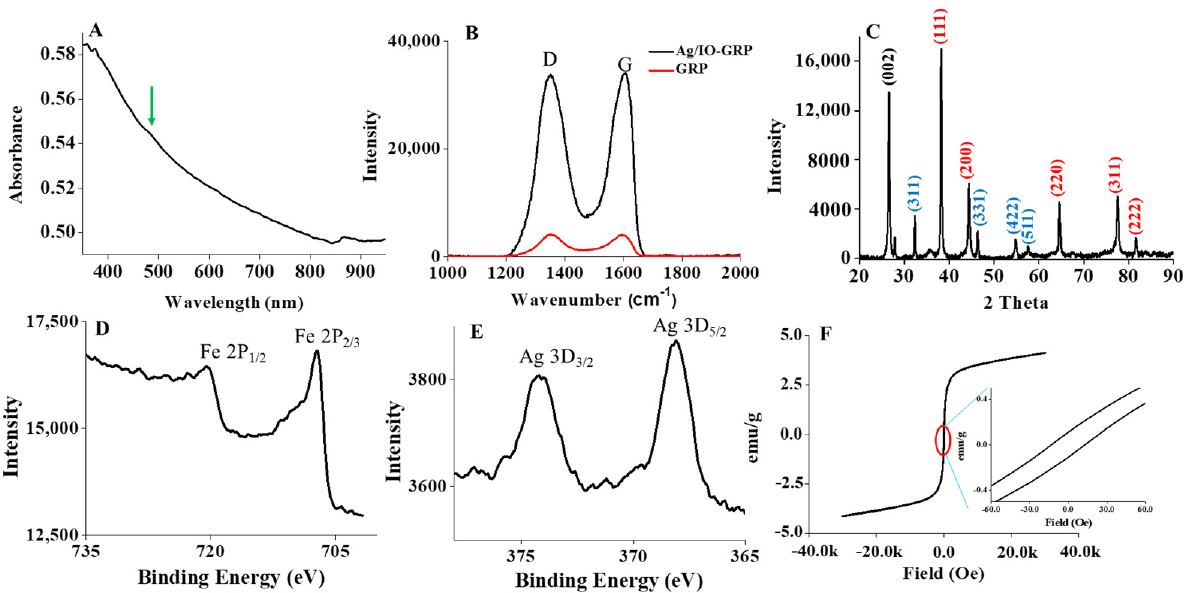
Figure 2. Physicochemical properties of Ag/IO-GRP: ( A ) UV/Vis spectrum, ( B ) Raman spectra, ( C ) XRD diffraction pattern, ( D , E ) XPS spectra, and ( F ) SQUID hysteresis.